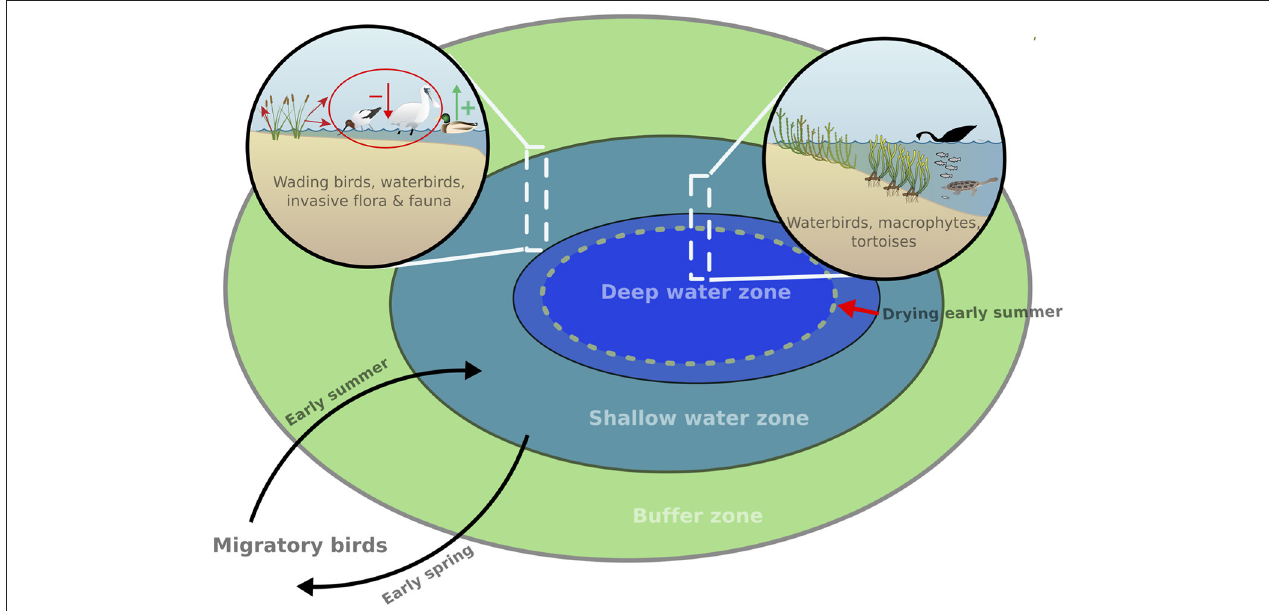
FIGURE 3 | Seasonal representation of the shallow ( < 0.5m) and deep surface water zones ( < 1.5m) of the lake. Prolonged droughts impact on wading birds due to an increase of invasive flora in the shallow water zone. Reduced habitat for waterbirds occurs when the surface area of the deep-water zone decreases and becomes shallower after prolonged dry periods. Wading birds and migratory birds decline due to the loss of muddy shorelines and increase of invasive flora species in the shallow water zone. Integration and Application Network [ian.umces.edu/media-library (Integration Application Network,